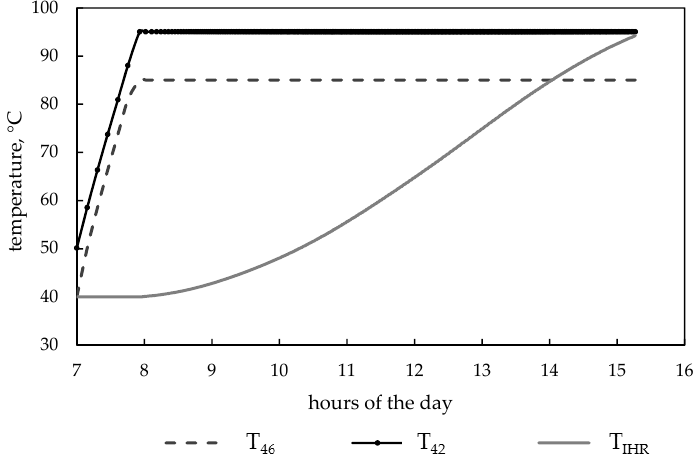
Figure 5. Off-design simulation of the charging phase (Reference day of May in Crotone)—temperature profile for the solar-thermal field and temperature increase of water in the IHR tank.